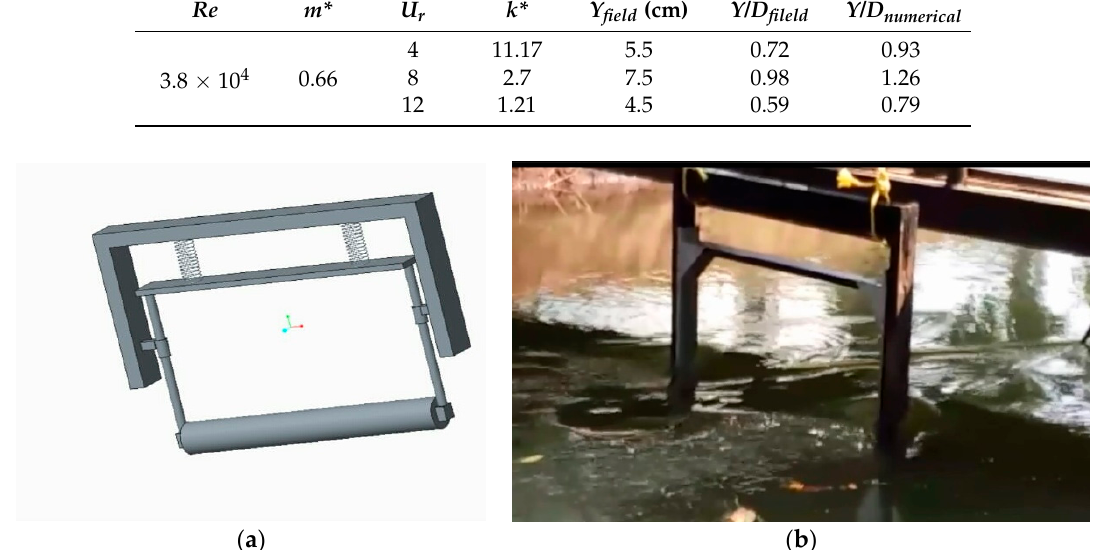
Figure 13. ( a ) Model of HVPG; ( b ) field test at Palissery irrigation canal for m* = 0.66 and U r = 4, 8, and 12.